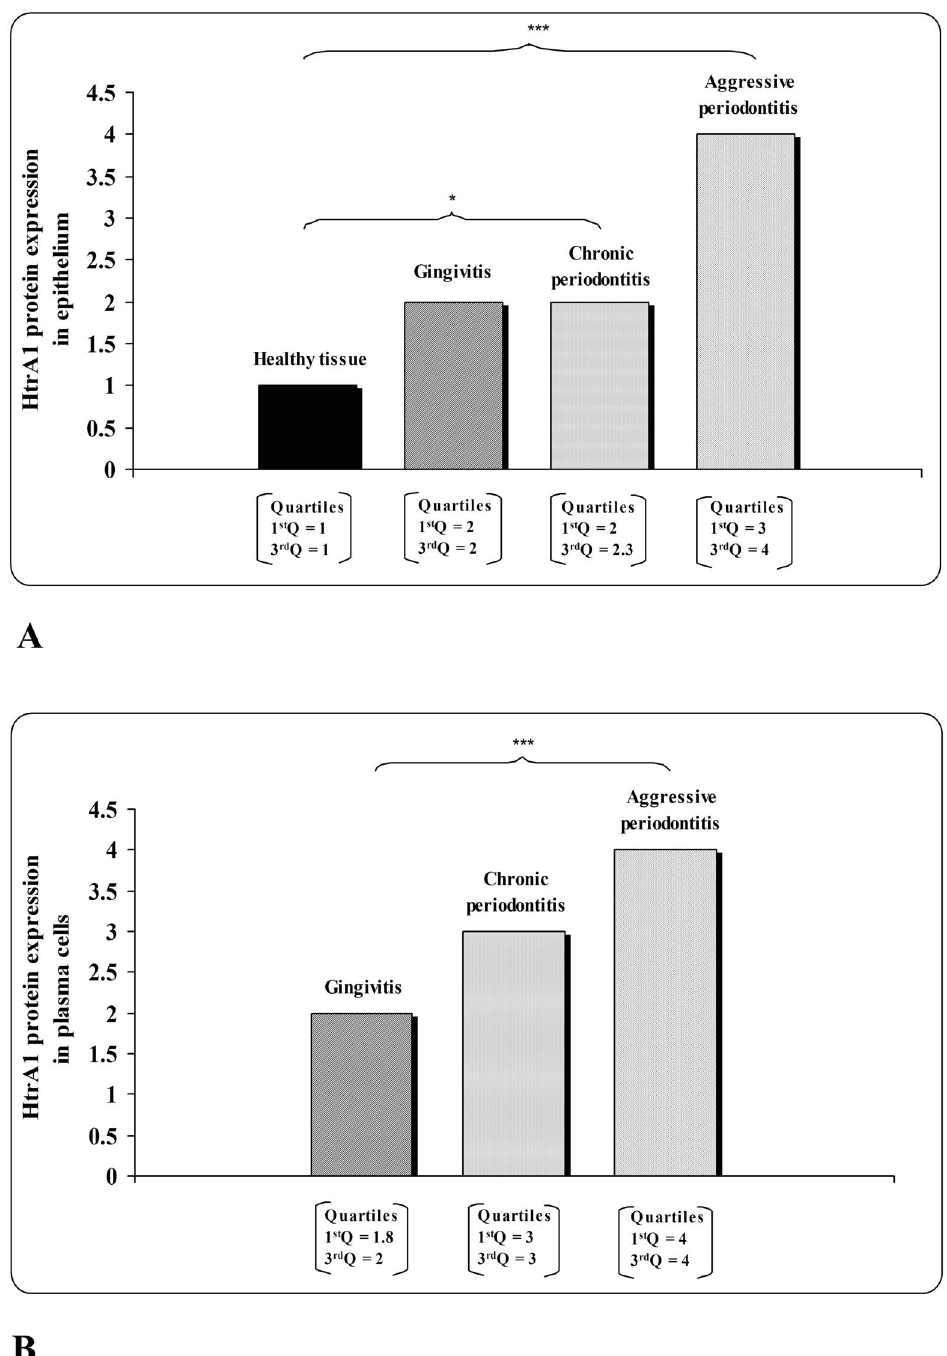
Figure 3. HtrA1 protein expression in A) epithelium and in B) plasma cells of studied groups. HtrA1 expression was classified with a five- point scale and was assigned a number value to each point: negative (neg=0), slight ( + / 2 =1), faint ( + =2), moderate ( ++ =3) and strong ( +++ =4). p , 0.05 (*); p , 0.001 (***).